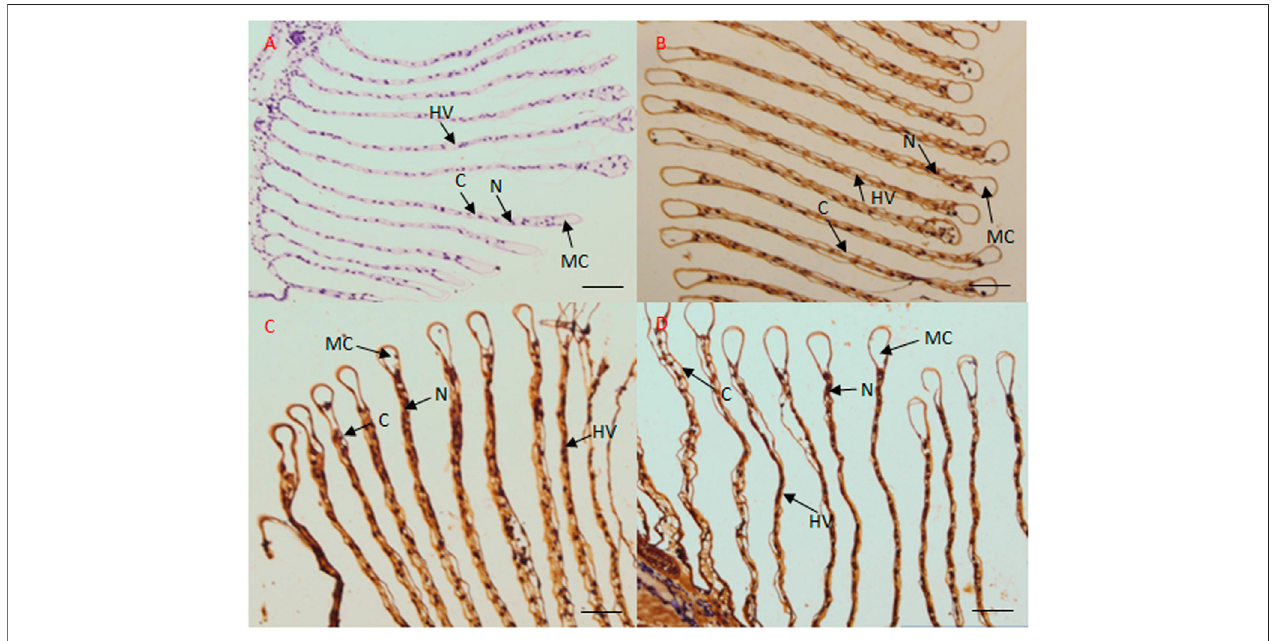
FIGURE6| LocalizationofCAtranscriptsinthegilltissueof M.nipponense by insitu hybridization.Senseprobeswereusedasnegativecontrols,whichgenerated no signal (A) . Inthe gilltissue, CAtranscripts mainlylocalizedtothe epithelial cellnuclei andhemolymphvessel underfreshwater (B) ,lowsalinity (C) ,and high salinity (D) conditions. MC, marginal channel; (C) cuticle; N, epithelial cell nuclei; HV, hemolymph vessel. Scale bar: 50 μ m.